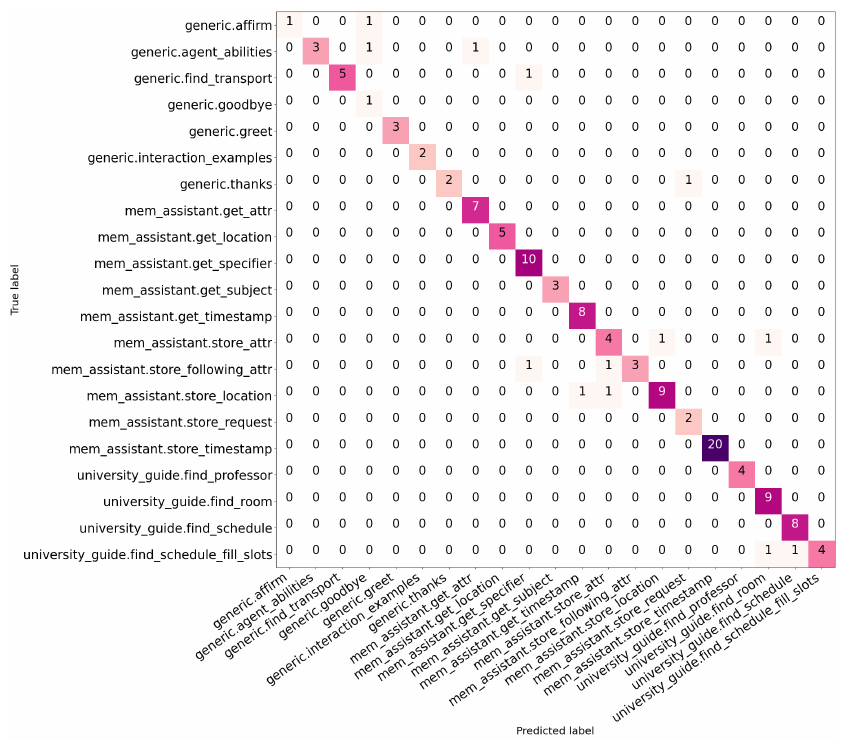
Figure 8. Multi-microworld intent classification’s confusion